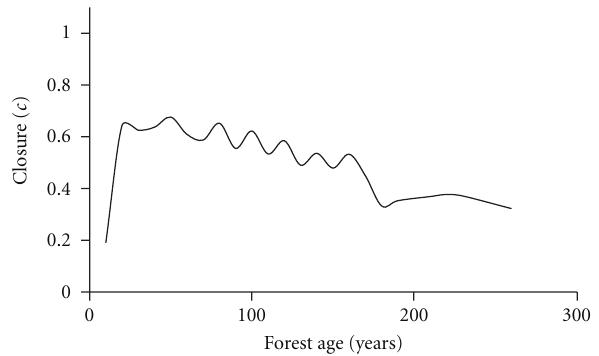
Figure 7: Mean closure ( c = stand density/maximum stand density at a fixed mean tree size) for all species and regions versus forest age (10-year intervals) predicted by model